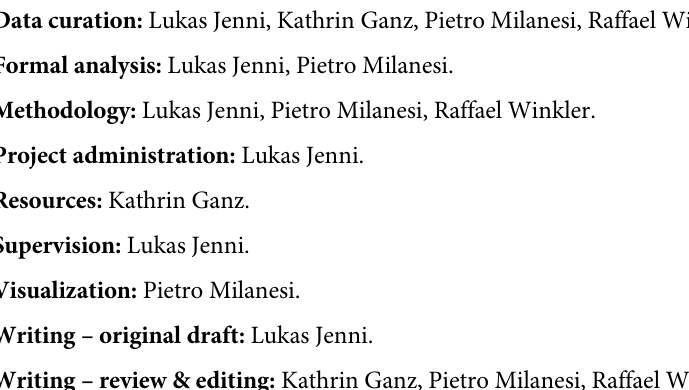
S1 Table. Measurements of the longest primary of 27 species. S2 Table. Reduced major axis (RMA) and phylogenetic RMA (PhyloRMA) regression of various parameters of the longest primary of 27 species. S3 Table. Reduced major axis regressions of various parameters of the remiges (primaries and secondaries of Golden Eagles. S4 Table. Linear mixed effects models applied to the parameters of Golden Eagle remiges. S5 Table. Reduced major axis regressions of various parameters of the primaries of 6 pas- serine species. S6 Table. Linear mixed effects models applied to the parameters of the primaries of 6 pas- serine